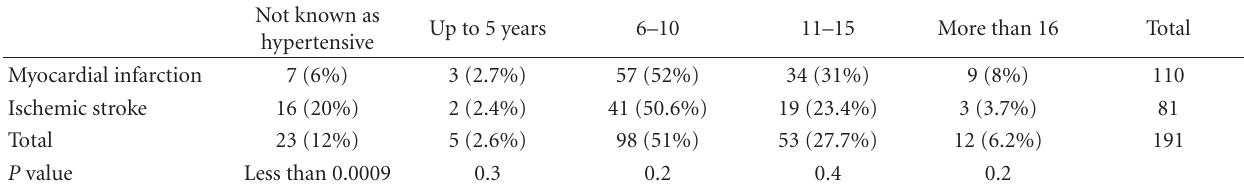
Table 2: Duration of hypertension in both myocardial infarction ischemic stroke groups.